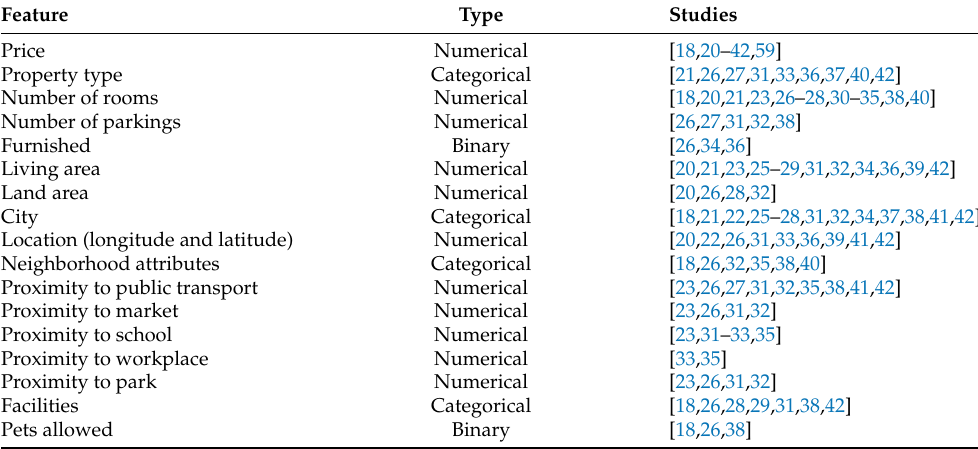
Table 4. The main Item features in real estate